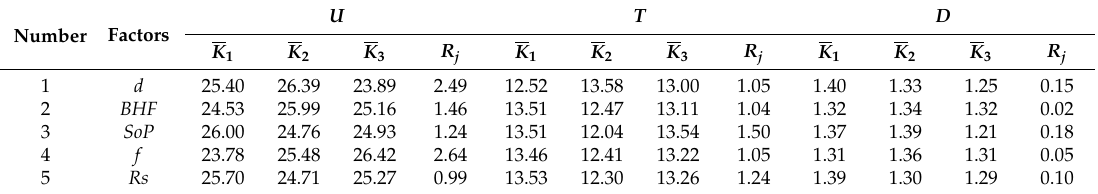
Table 9. Results of the intuitive analysis of the orthogonal experimental design of the combined process.